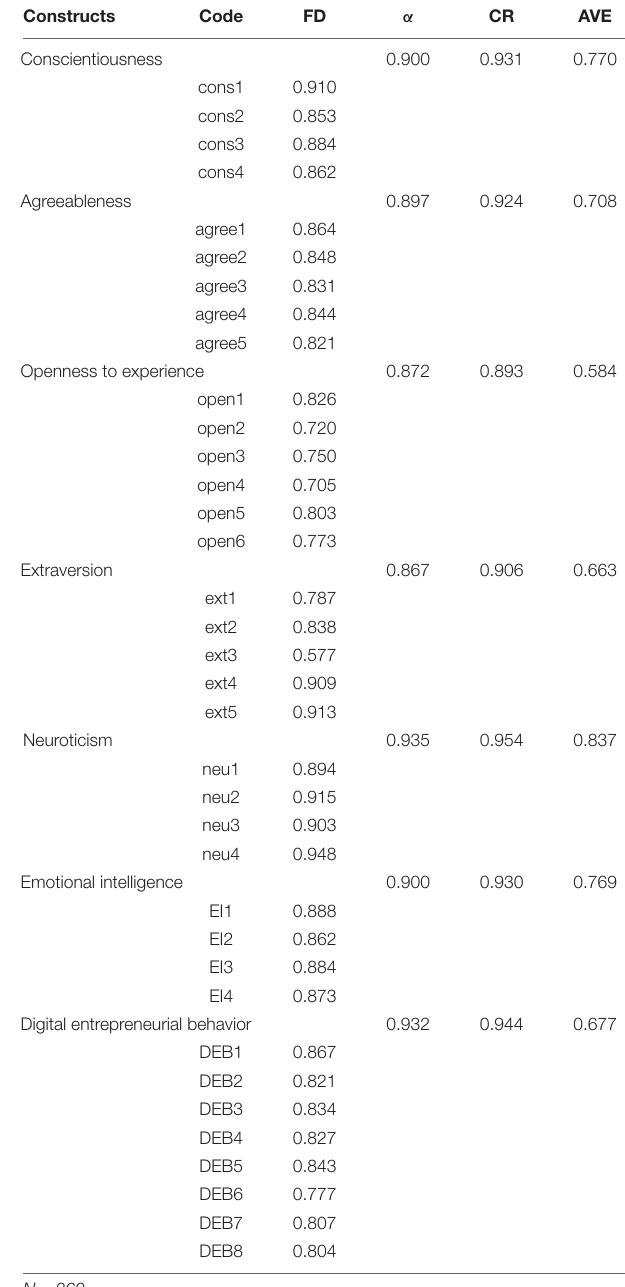
TABLE 1 | Demographic summary. TABLE 2 | Reliabilities and variance